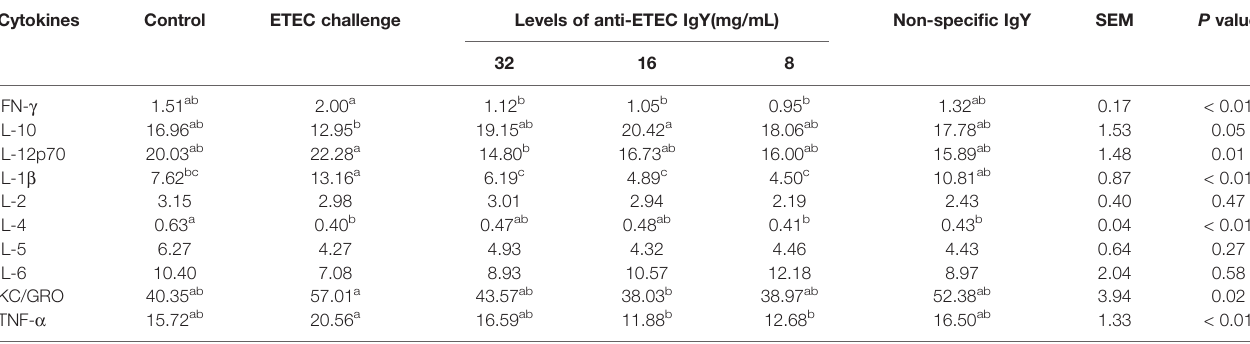
TABLE 3 | Effects of IgY on serum cytokines of mice challenged by ETEC K88. Cytokines Control